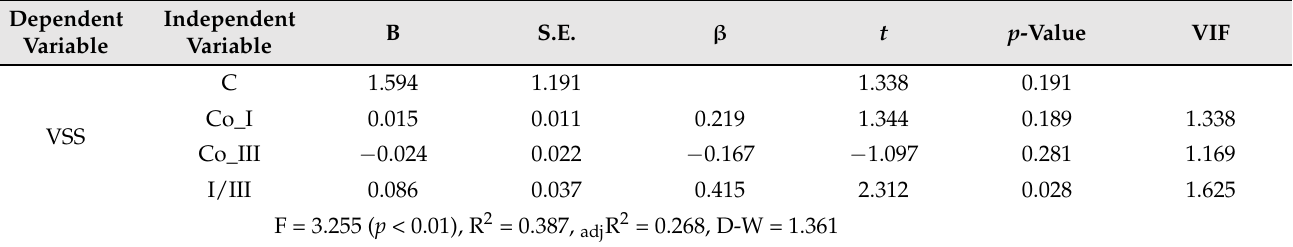
Table 5. Multiple regression analysis of Vancouver Scar Scale (VSS) and correlating